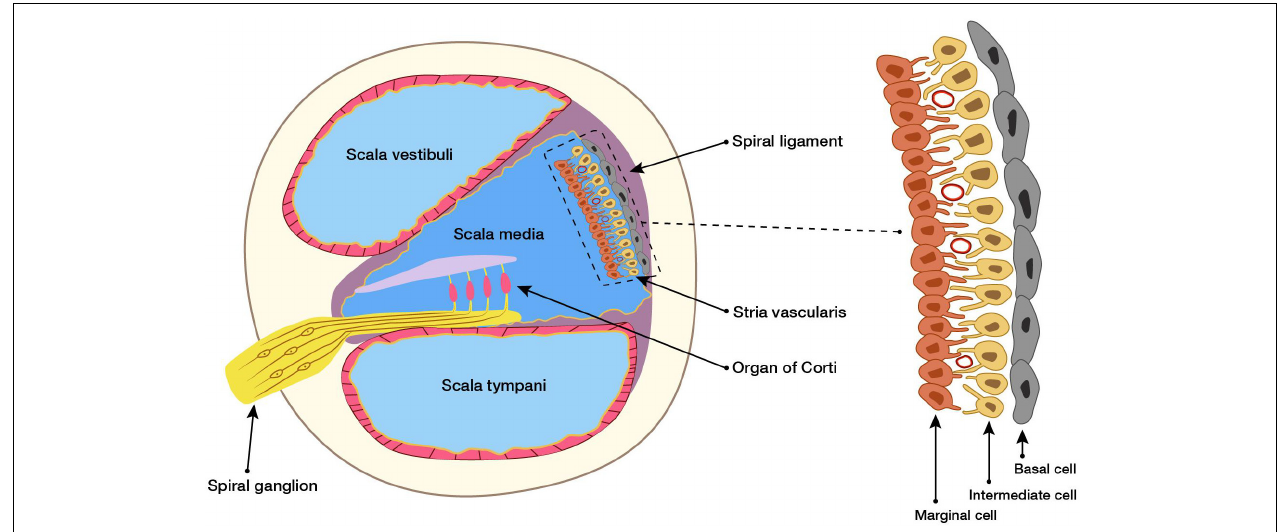
FIGURE 1 | Cross section of the cochlea and structure of SV. Structural and functional damage caused by the SV causes hearing loss, but the mechanism underlying this is unclear. Here, our study reviews the research on the SV in SNHL of different etiologies, and concluded the possible role of the SV in the pathogenesis of SNHL, and aimed to identify new opportunities for the clinical prevention and treatment of